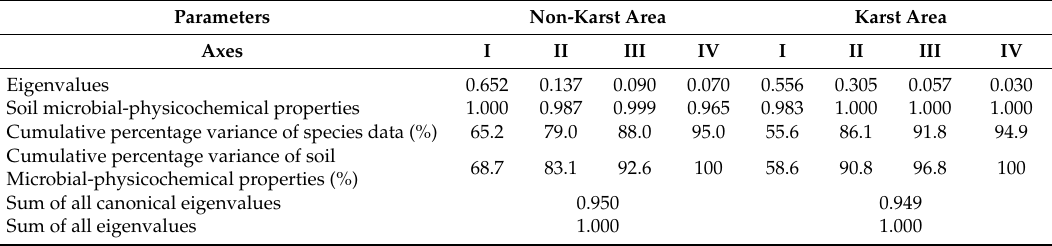
Table 5. Importance order of the explanation of the physical and chemical factor variation.